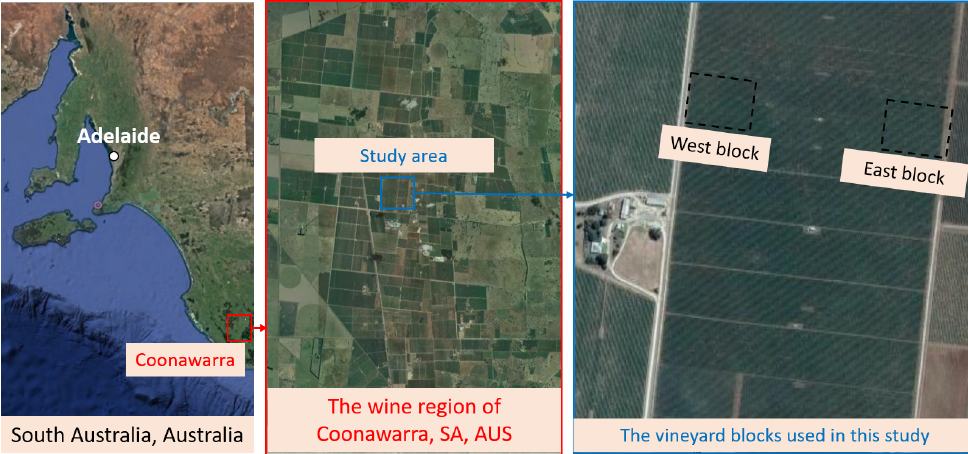
Figure 1. Two Cabernet Sauvignon vineyards at the Wynns Coonawarra Estate, Coonawarra, SA, Australia used in this study of crop coefficient and irrigation